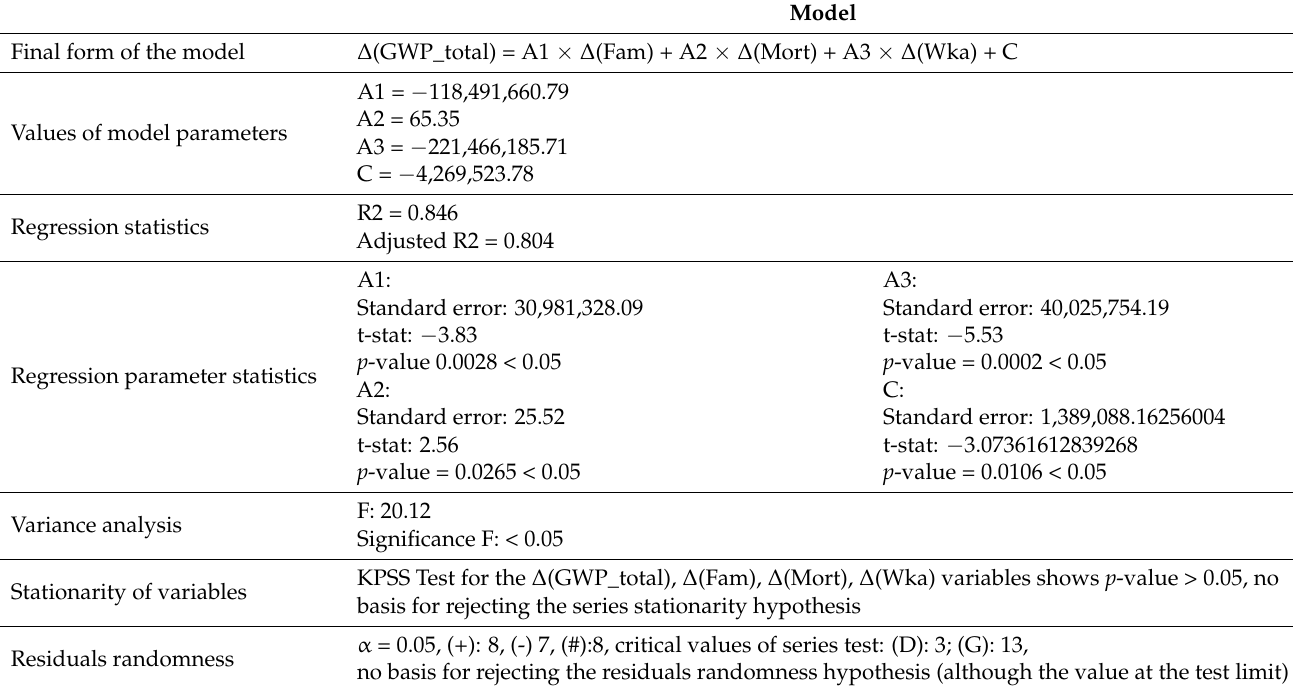
Table 6. Results of regression